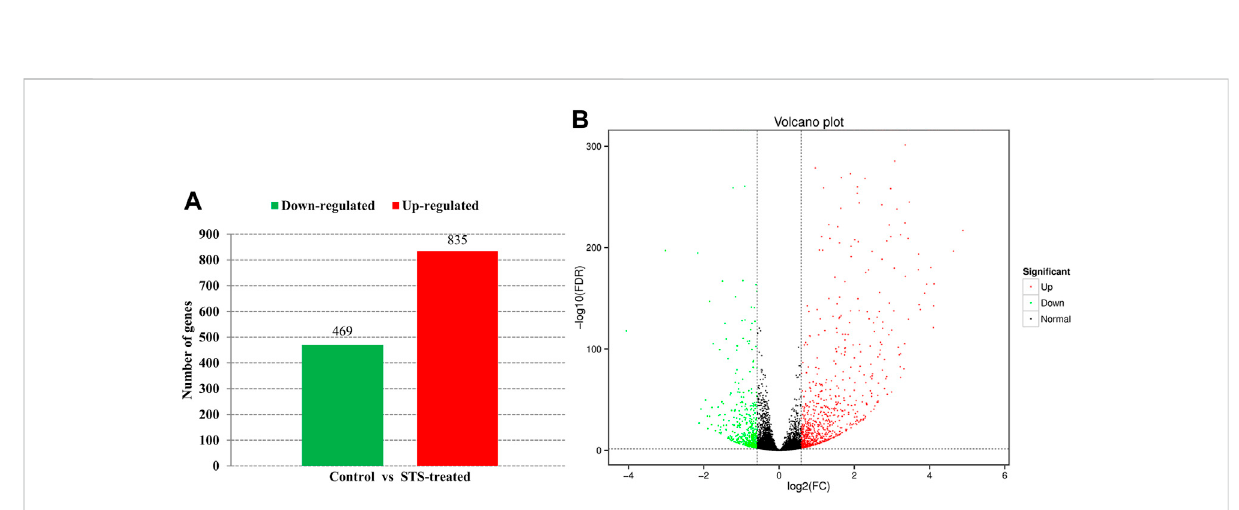
FIGURE 2 Differentially expressed genes (DEGs) between silver thiosulfate (STS)-treated plants and control plants. (A) Numbers of upregulated and downregulated genes. (B) Volcano map of the gene